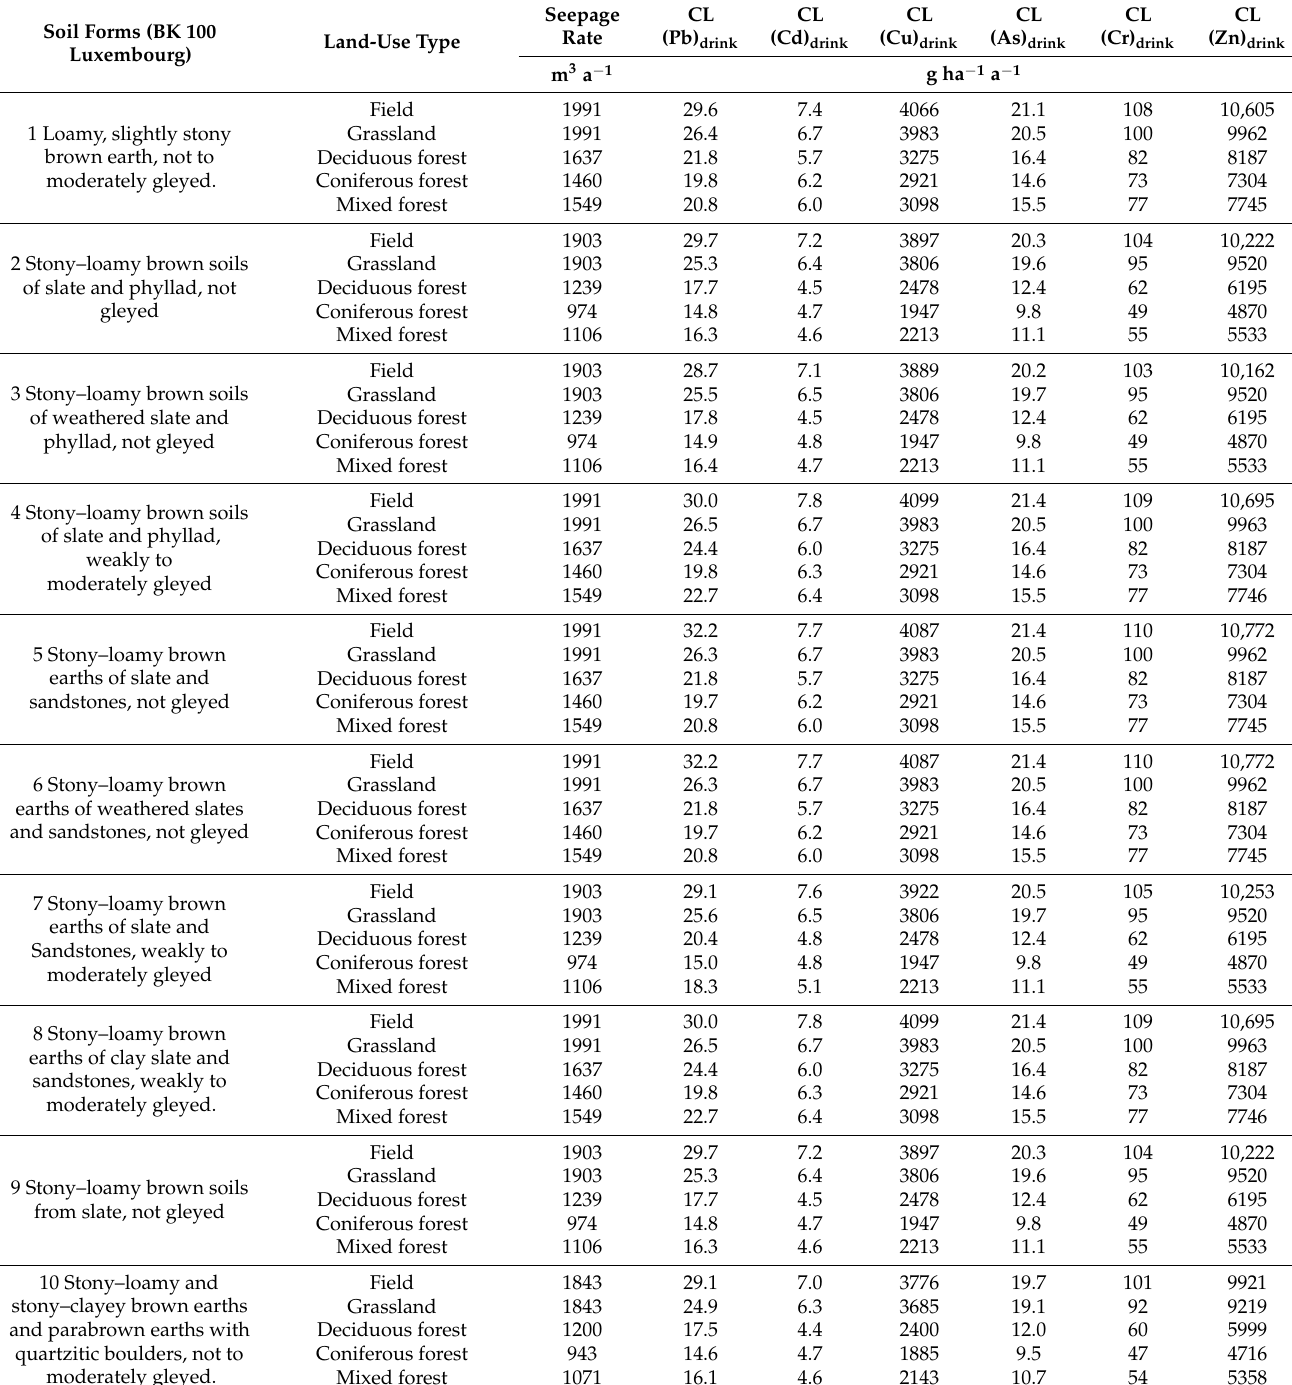
Table 17. Values of the critical loads for drinking water protection in